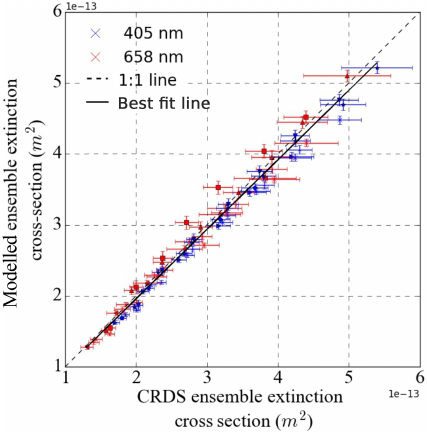
Figure 6. Modelled versus CRDS-measured extinction cross sec- tions for nigrosin aerosol at 405 and 658nm wavelengths.